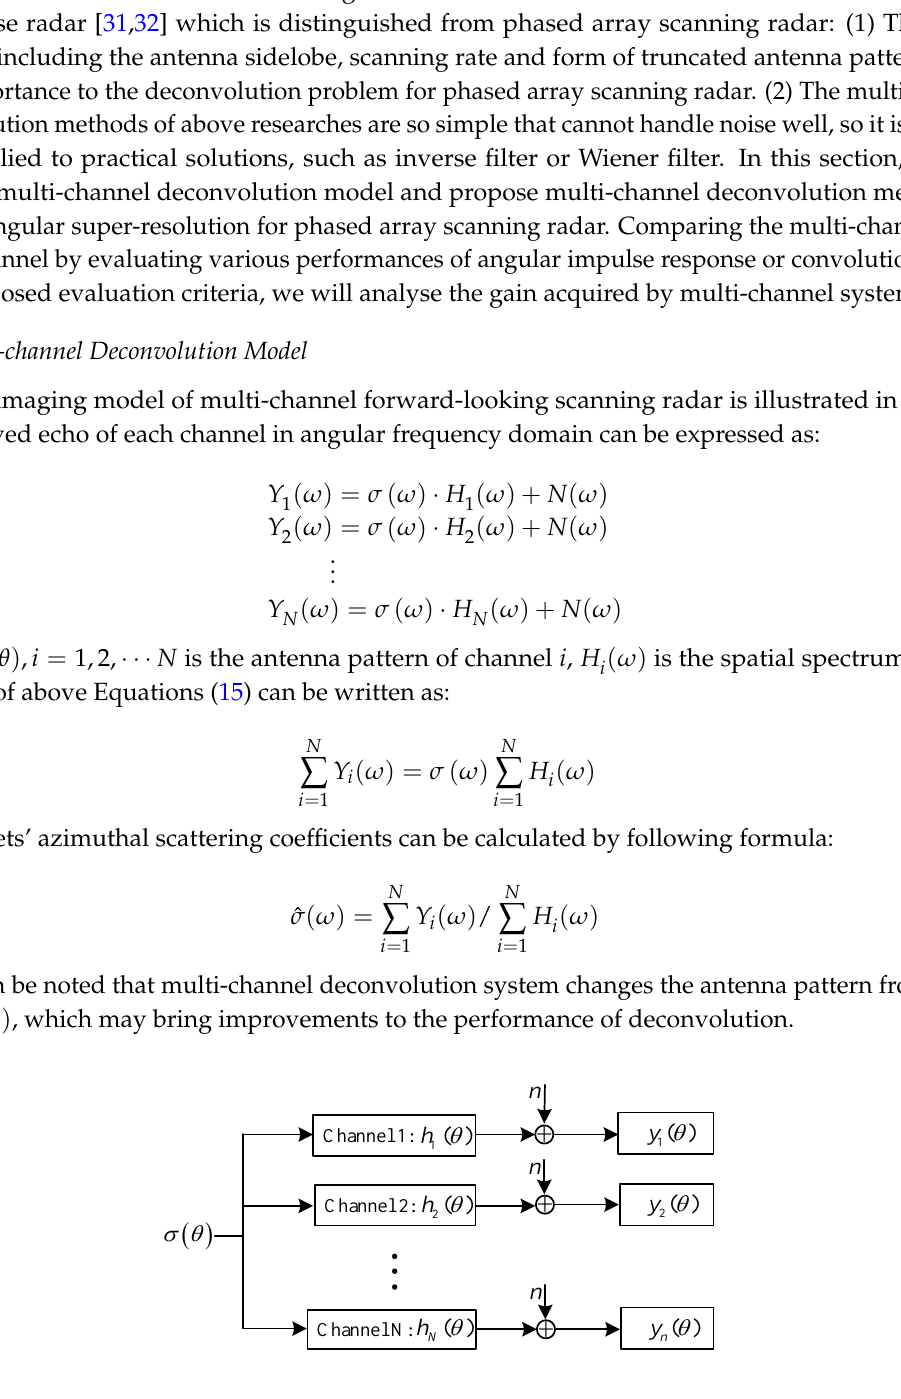
Figure 4. Multi-channel imaging model for forward-looking scanning